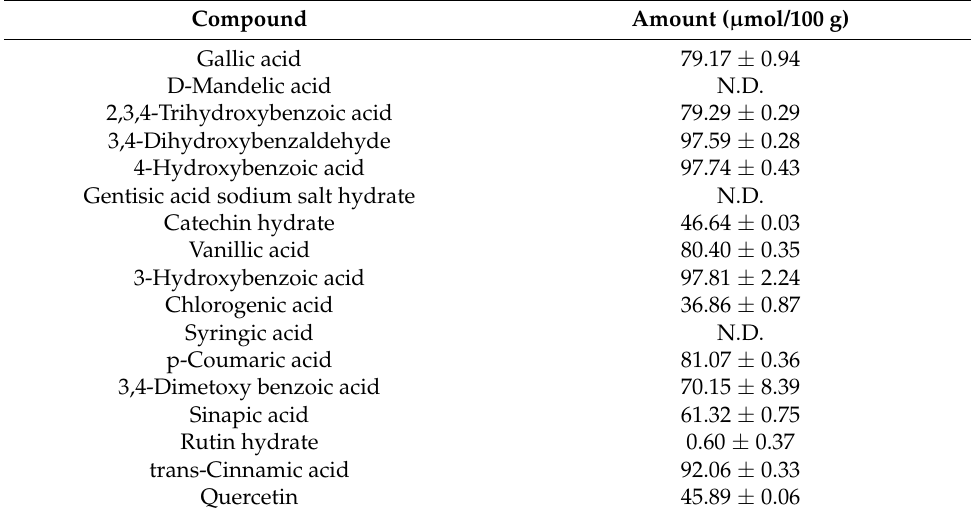
Table 2. Polyphenol composition in